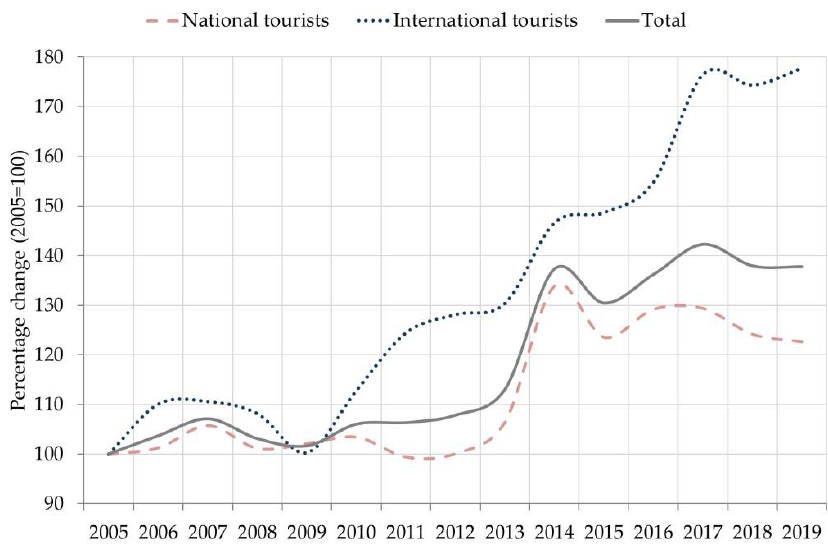
Figure 2. Percentage change of tourists staying overnight in hotels (Base 100 = 2005). Source: Authors’ own elaboration based on data from the hotel occupancy survey of the Instituto Nacional de Estadística (INE) de España [77].